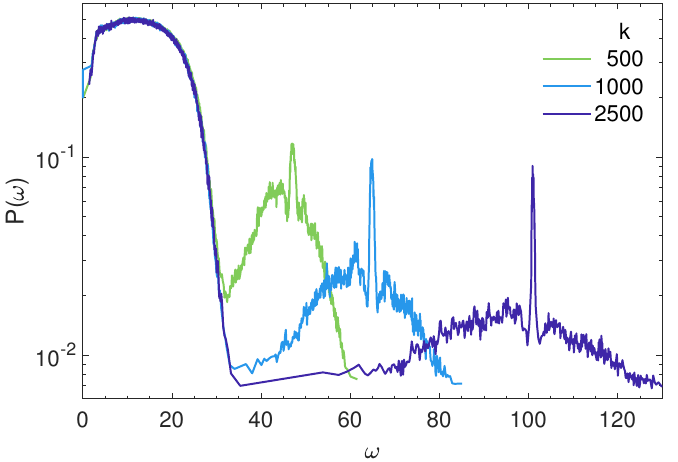
Figure 2. Participation ratio of the mode with frequency ω , Equation (8), for different stiffnesses of the spring bonding adjacent monomers of the same chain. For a plane wave, P ( ω ) =